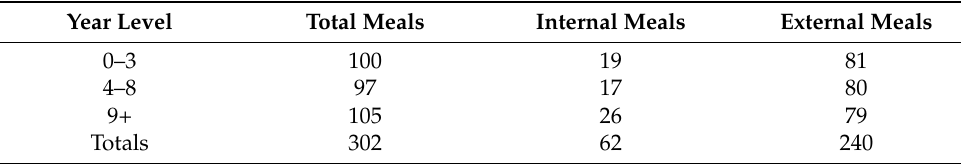
Table 2. Breakdown of the meals included in this